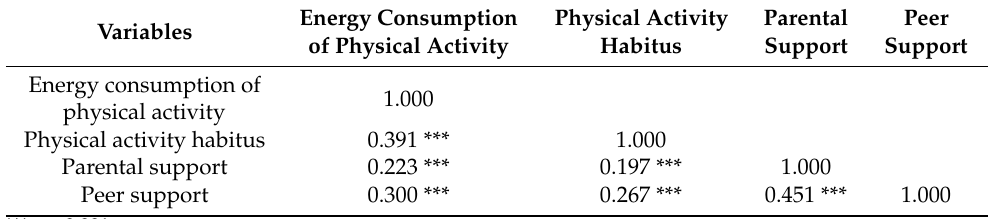
Table 4. Correlation